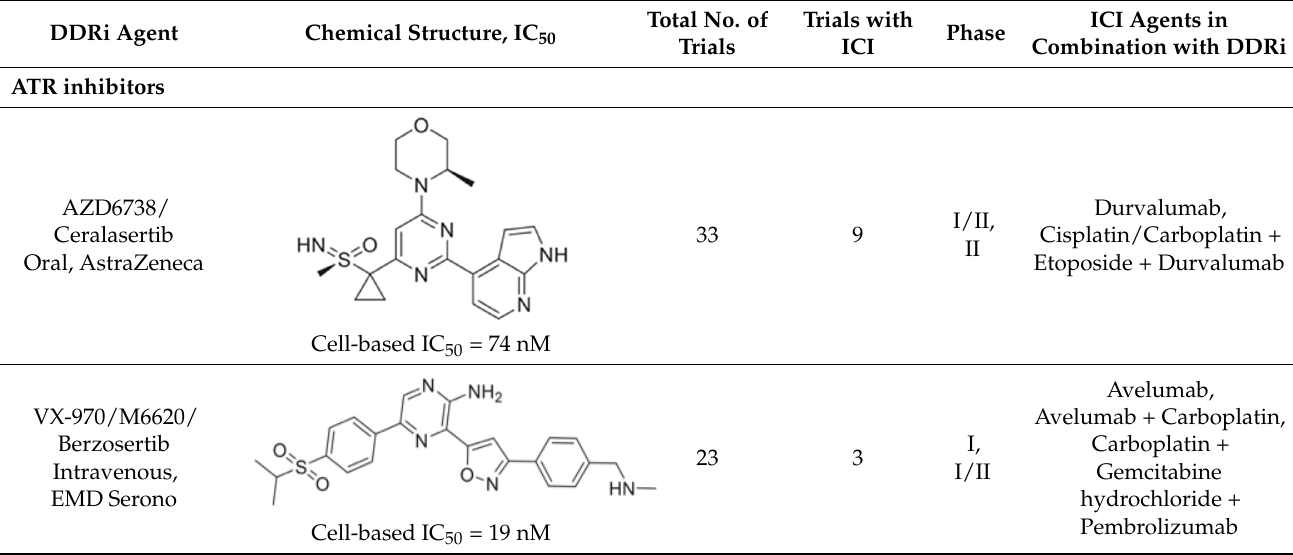
Table 1. Clinical trials pairing DNA damage response inhibitors (DDRi) with immune checkpoint inhibitors (ICIs). The inhibitory concentration (IC 50 ) indicates the potency of the inhibitor. ATM is not listed because no ICI combinations with ATM were listed on clinicaltrials.gov at the time of review.